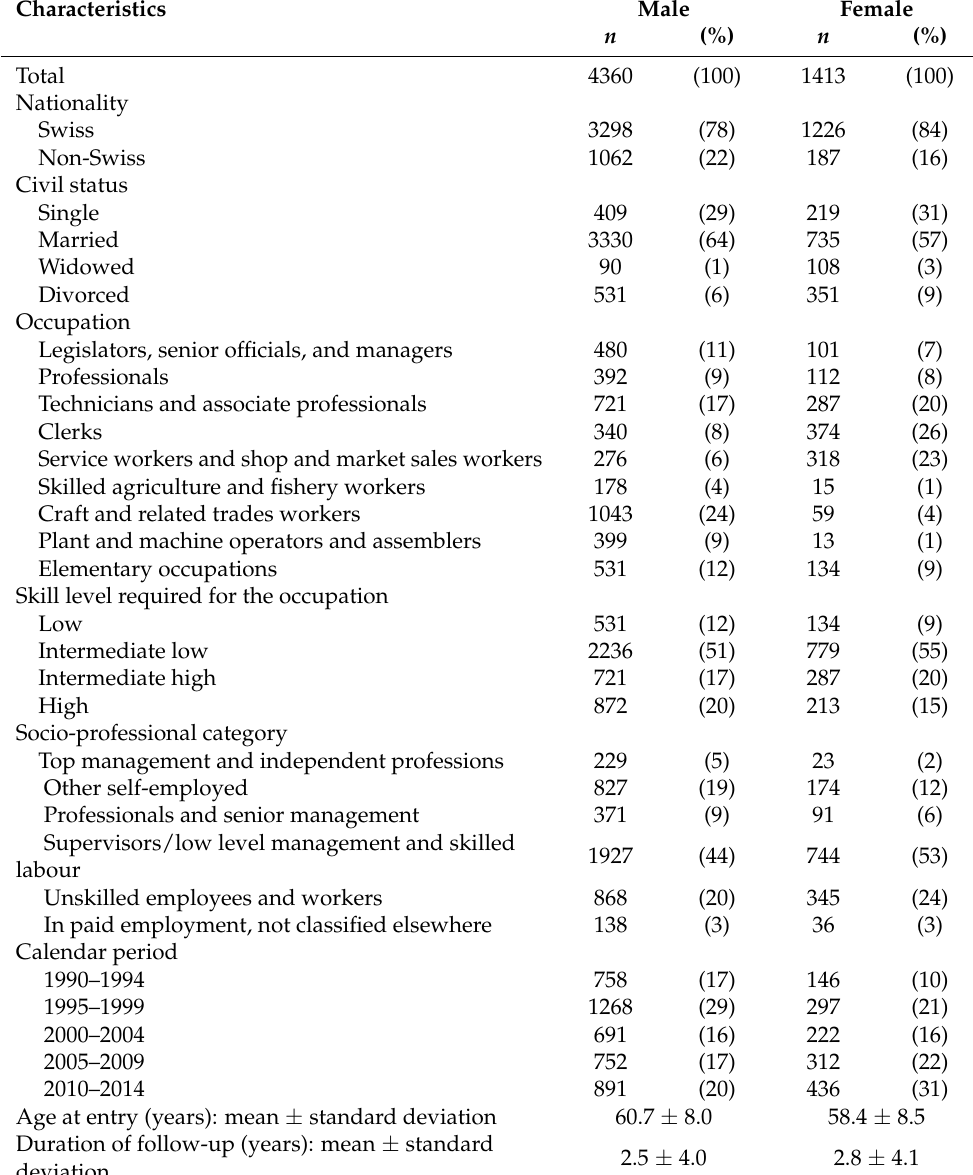
Table 1. Description of the study sample: Incident lung cancer cases in French-speaking Switzerland